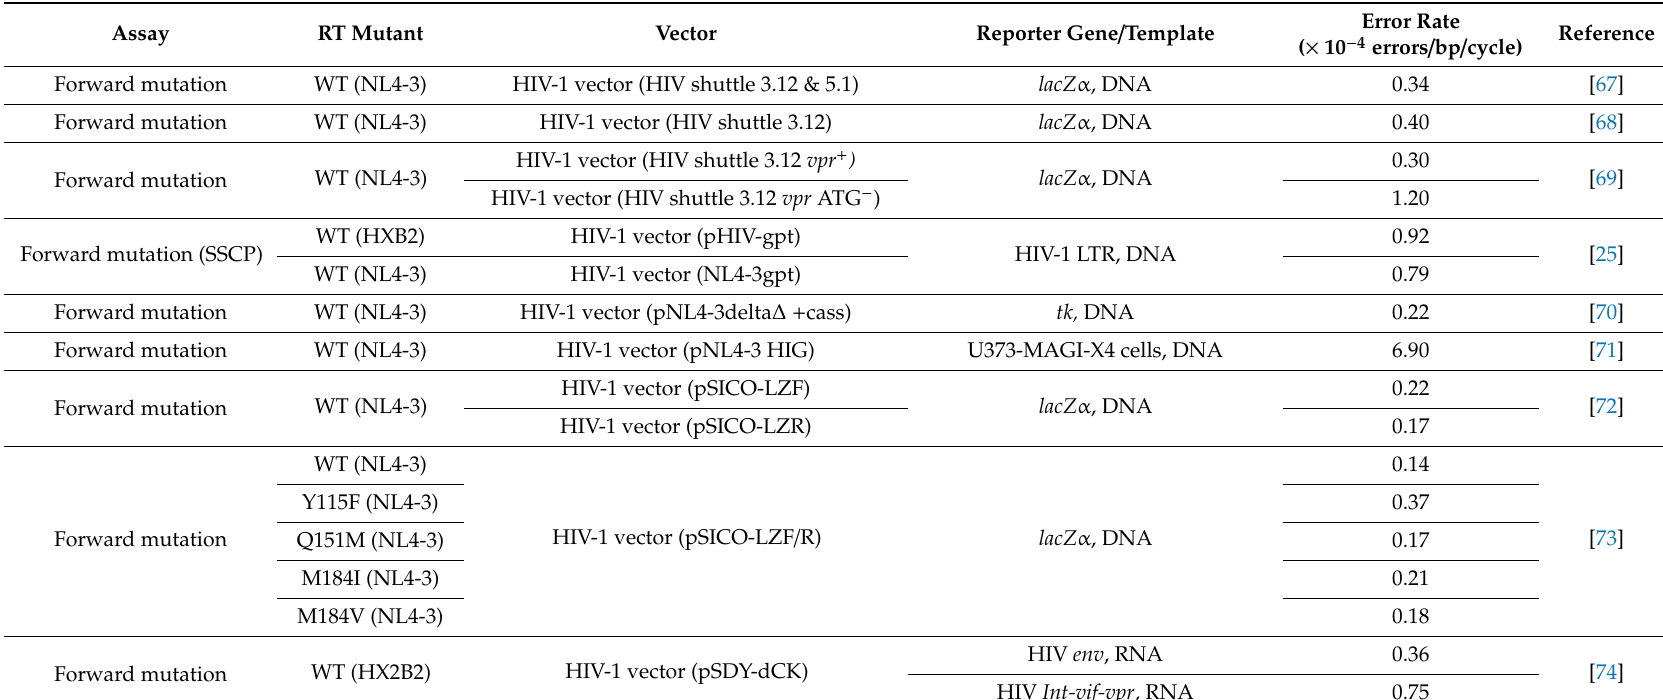
Table 3. Error rates of HIV-1 RT measured in cell-based fidelity assays.